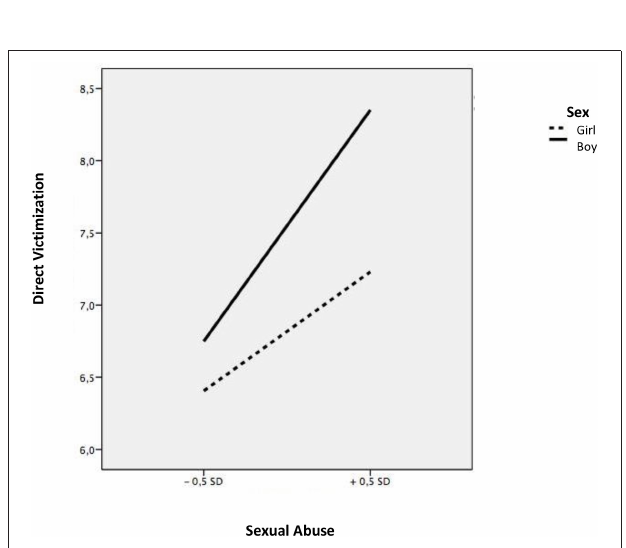
FIGURE 3 | Interaction between sexual abuse and sex in relation to cyberbullying victimization.